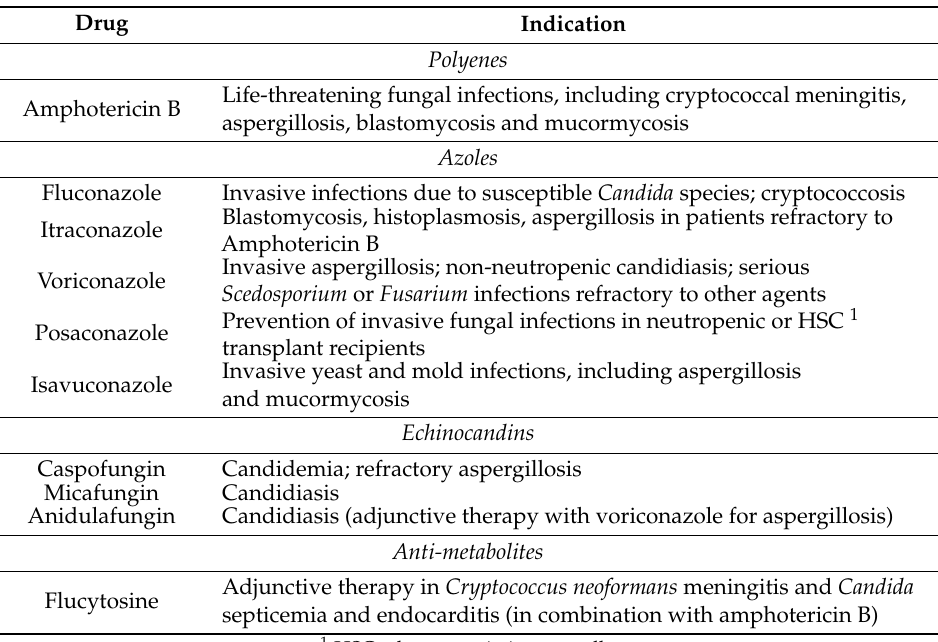
Table 3. Approved antifungal drugs for the treatment of invasive fungal infections. Drug Indication Polyenes Life-threatening fungal infections, including cryptococcal meningitis, Amphotericin B aspergillosis, blastomycosis and mucormycosis Azoles Fluconazole Invasive infections due to susceptible Candida species; cryptococcosis Blastomycosis, histoplasmosis, aspergillosis in patients refractory to Itraconazole Amphotericin B Invasive aspergillosis; non-neutropenic candidiasis; serious Voriconazole Scedosporium or Fusarium infections refractory to other agents Prevention of invasive fungal infections in neutropenic or HSC 1 Posaconazole transplant recipients Invasive yeast and mold infections, including aspergillosis Isavuconazole and mucormycosis Echinocandins Caspofungin Candidemia; refractory aspergillosis Micafungin Candidiasis Anidulafungin Candidiasis (adjunctive therapy with voriconazole for aspergillosis) Anti-metabolites Adjunctive therapy in Cryptococcus neoformans meningitis and Candida Flucytosine septicemia and endocarditis (in combination with amphotericin B) 1 HSC = hematopoietic stem